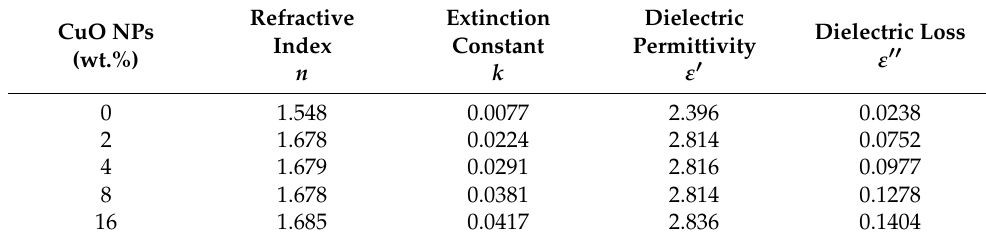
Table 1. The refractive index ( n ), extinction coefficient ( k ), dielectric permittivity ( ε (cid:48) ), and dielectric loss ( ε ” ) of PMMA–PVA/CuO NPs thin films for different concentrations of CuO NPs at λ = 550 nm. CuO NPs